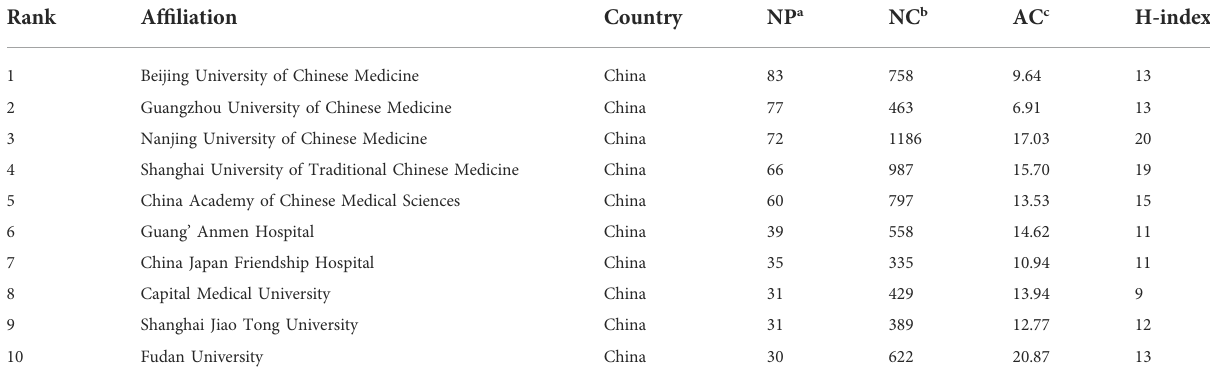
TABLE 2 Topmost 10 productive institutions in the fi eld of herbal medicine to control CKD. Rank